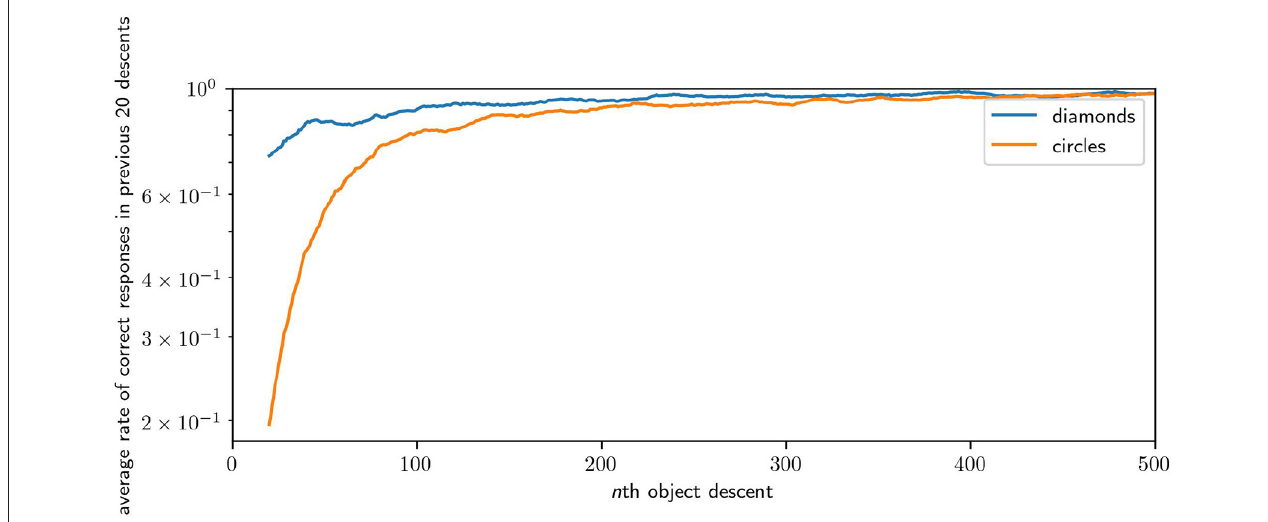
FIGURE 12 | Plot of the improving performance of robots, averaged across 64 runs. Although this figure only shows the first 500 interactions with each shape because most of the development occurs early, performance continued to improve incrementally for the remaining 1,500 interactions.